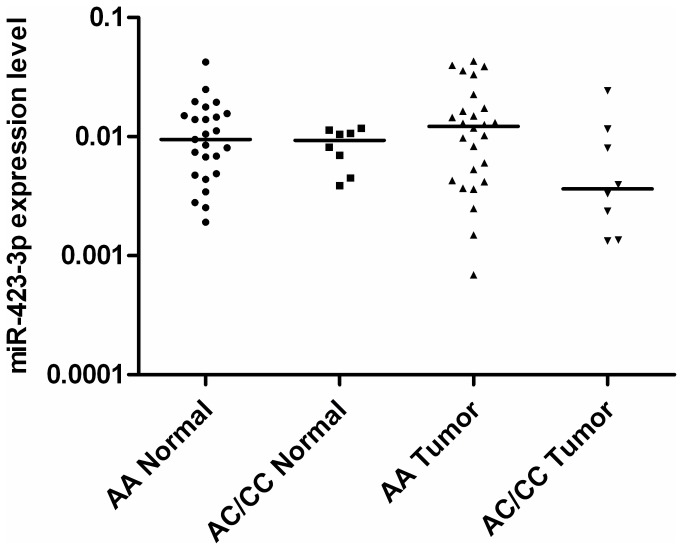
Expression of miR-423-3p does not correlate with rs6505162 genotypes.miR-423-3p levels were determined for different genotypes in normal and tumour tissue samples from OSCC patients (N = 32), respectively (bars show group mean values). All values were normalized to 18s RNA levels. Kruskal–Wallis one-way analysis of variance was used to evaluate differences in expression levels between groups. Mean values for rs6505162 genotypes are: 1.162*10-2 (AA, normal), 8.489*10-3 (AC/CC, normal), 1.487*10-2 (AA, tumour), and 7.029*10-3 (AC/CC, tumour).